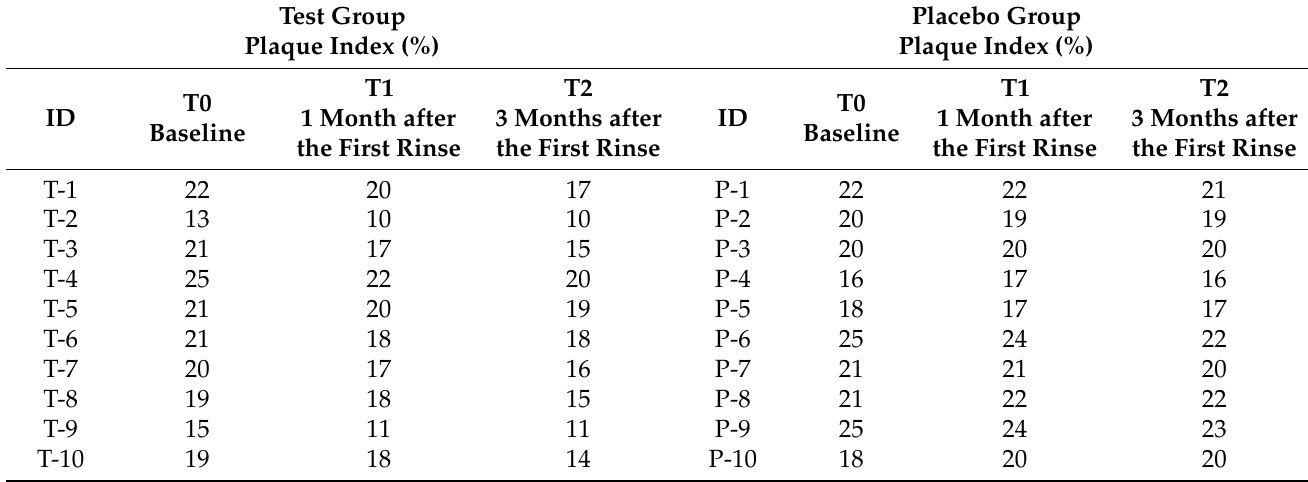
Table 2. Plaque index in the Test group and the Placebo Group at different times. Test Group